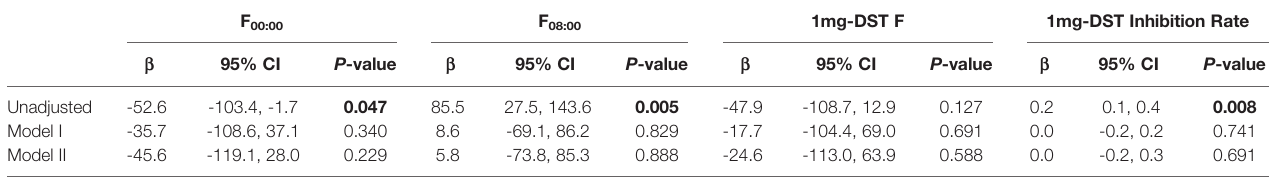
TABLE 6 | Logistic regression used to evaluate the difference in autonomous cortisol secretion between female MACS patients of different menopausal